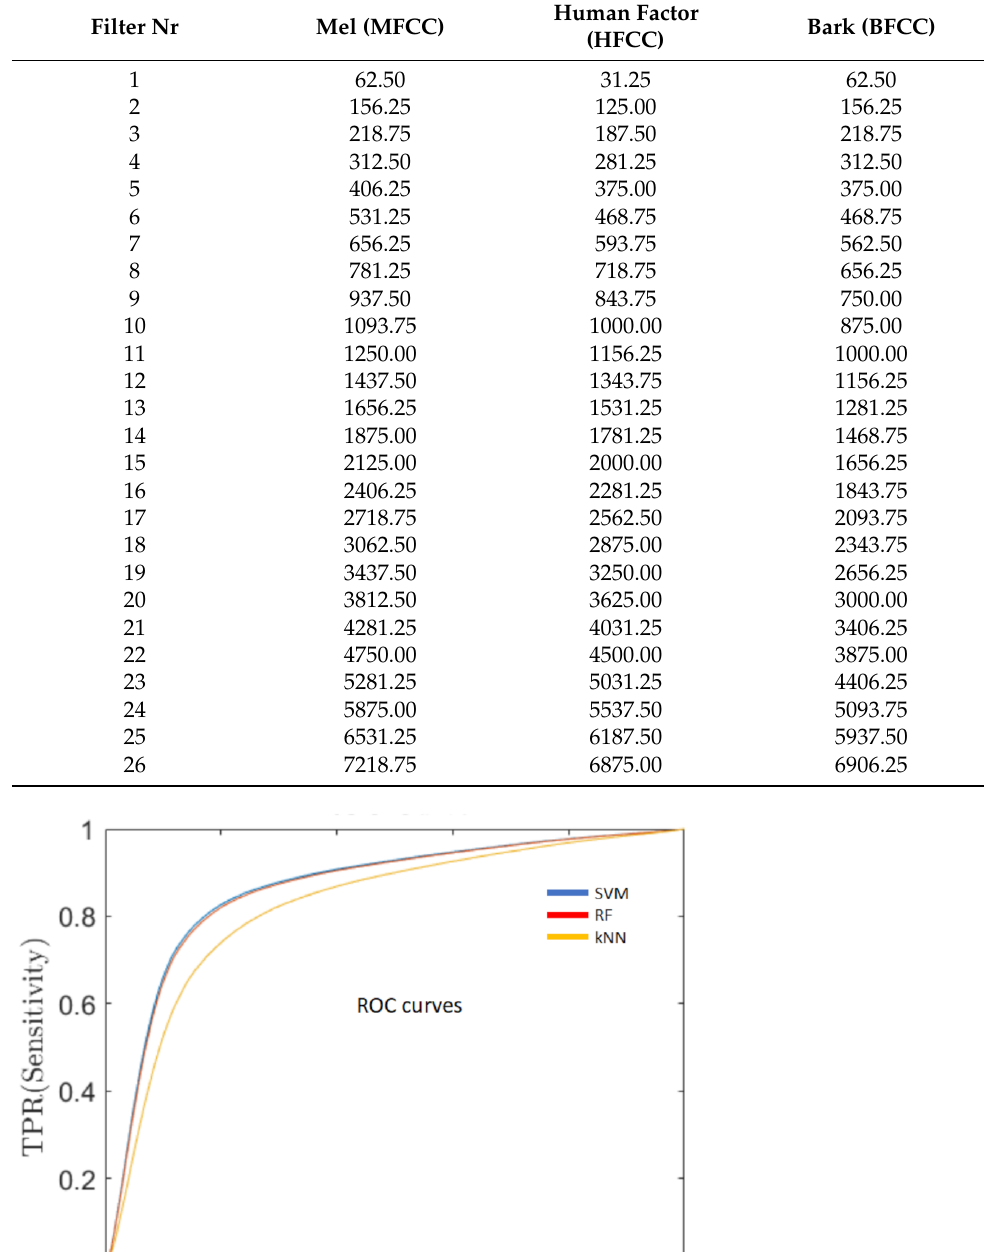
Table 1. Central frequencies corresponding to each of the 26 filters for the three scales employed in this study: Mel, Human Factor, and Bark.